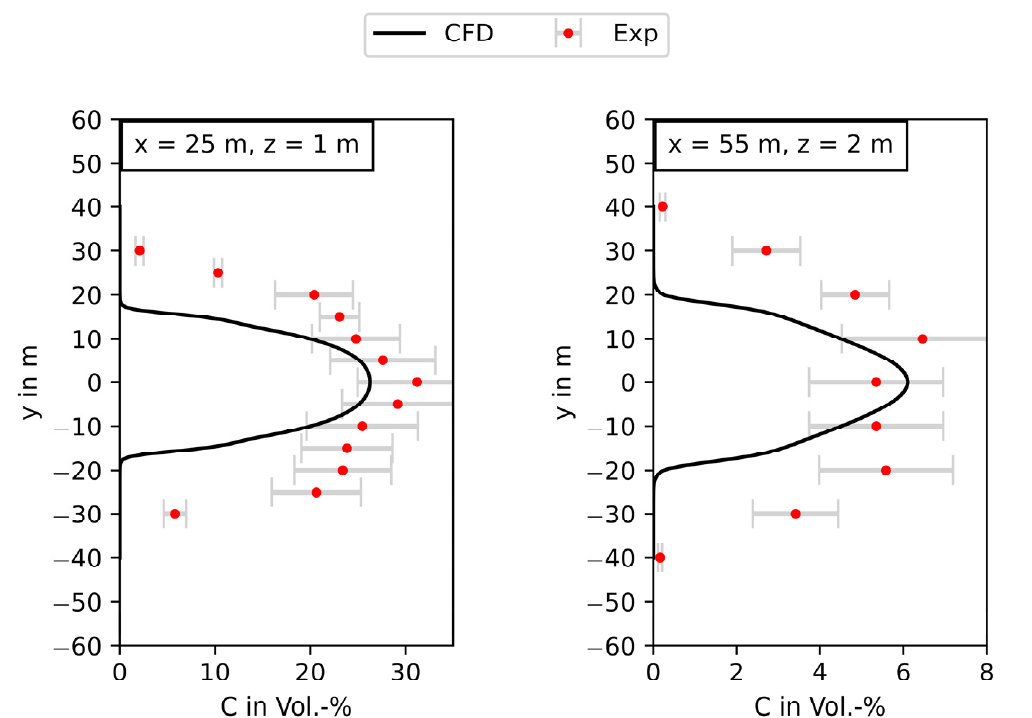
Figure 10. Heavy gas cloud width in a distance of 25 m ( left ) and 55 m ( right ) to the origin, corre- sponding to 5 m and 35 m to the source, respectively.